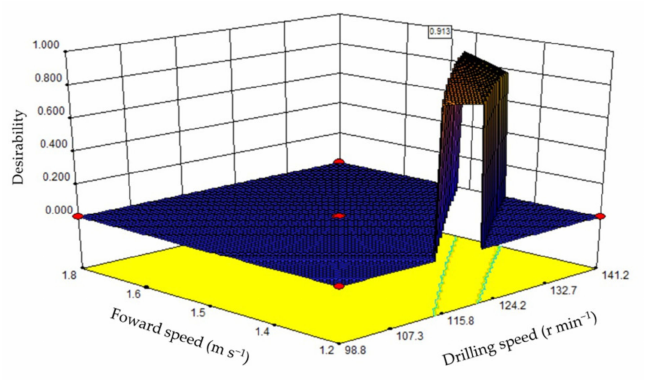
Figure 15. Optimization of optimal operating parameter